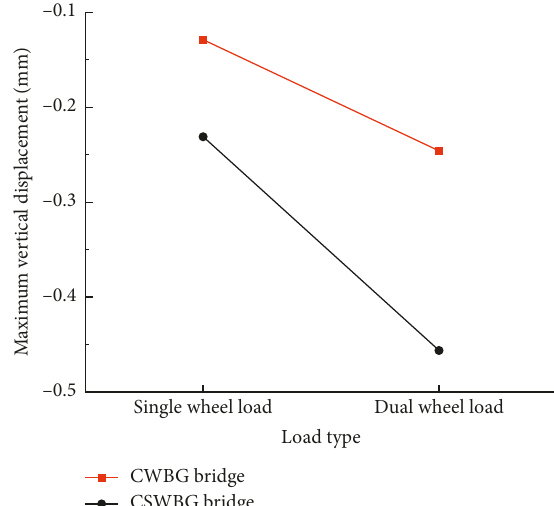
Figure 7: Comparison of maximum vertical displacement on the surface of the bridge deck pavement at the same speed.